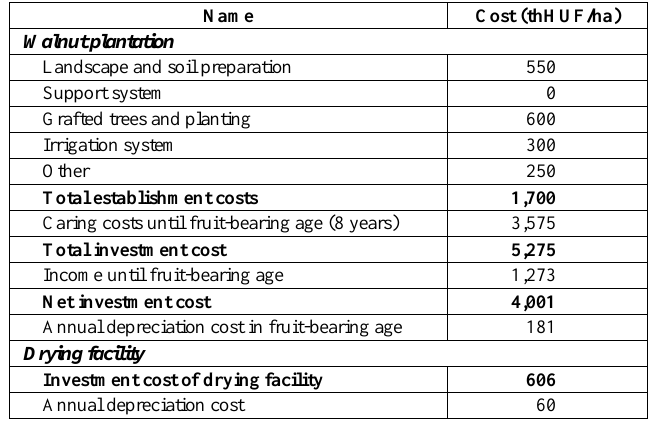
Table 1. Investment cost of the examined walnut orchard and drying facility